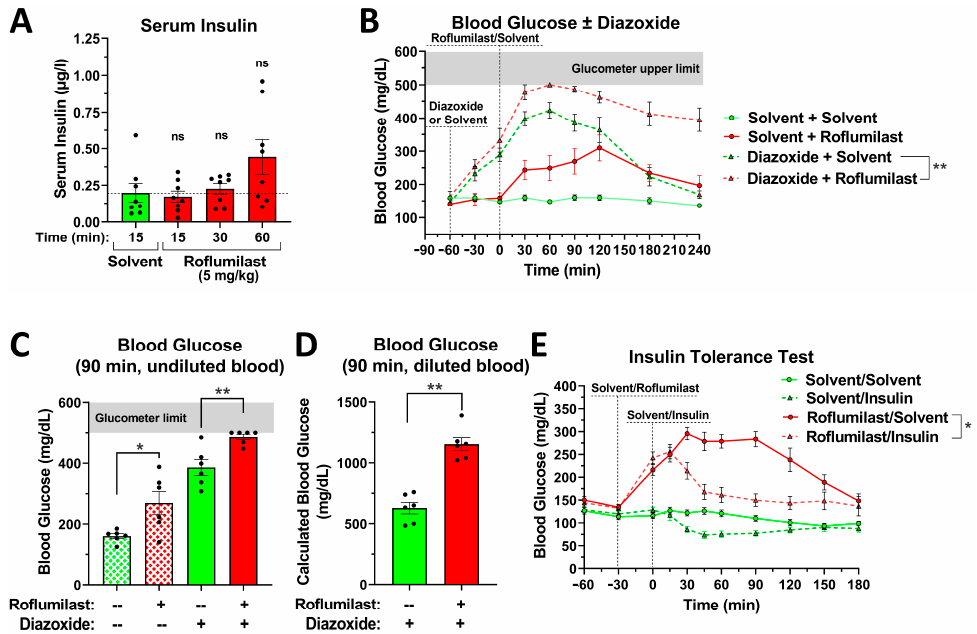
Figure 4. The acute glycemic effects of PDE4 inhibition are not driven by changes in insulin secretion or tissue insulin sensitivity. ( A ) PDE4 inhibition does not lower serum insulin levels. Shown are insulin levels measured in serum of postprandial mice that had been cheek-bled at the indicated times after injection of the PDE4 inhibitor roflumilast (5 mg/kg; i.p.) or solvent control. ( B – D ) Inhibition of insulin release with diazoxide elevates blood glucose levels via a mechanism that is distinct and additive to that of PDE4 inhibition. After 5 h of food deprivation, mice were injected with diazoxide (25 mg/kg; i.p.; n = 6; − 60 min time point) or solvent control, followed 60 min later by a second injection with either the PAN-PDE4 inhibitor roflumilast (5 mg/kg; i.p.; 0 min time point) or solvent control. The glucometer used to measure blood glucose at tail pricks does not read above the upper limit of 500 mg/dL glucose that is indicated by the grey-shaded area. Treatment with roflumilast significantly ( p < 0.01) increased blood glucose levels compared to solvent controls, in both the absence and presence of diazoxide. In ( C , D ), blood glucose levels measured at 90 min after PDE4 inhibitor treatment in the same mice are reported. ( C ) shows the blood glucose levels measured in undiluted blood directly at the mouse tail-vein prick, leading to 4 out of 6 mice in the “diazoxide/roflumilast” group reading at the detection limit of 500 mg/dL. In ( D ), shown are calculated blood glucose levels for the diazoxide-treated groups that were measured after diluting 1 µL of tail-vein blood 1:5 with PBS, thus obtaining readings in the normal range of the glucometer. ( E ) PDE4 inhibition does not impair insulin sensitivity. After 5 h of food deprivation, mice were injected with the PDE4 inhibitor roflumilast (5 mg/kg; i.p.; n ≥ 10; − 30 min time point) or solvent control, followed 30 min later with an injection of insulin (Humulin R; i.p.; 0 min time point) or solvent control. Shown are blood glucose measurements at tail-vein pricks at the indicated time points. The injection of insulin induced a significant reduction ( p < 0.001) in blood glucose levels, in both the absence and the presence of roflumilast. All data represent the mean ± SEM. Statistical significance was determined using the Mann–Whitney test (bar graphs comparing two groups) and the Kruskal–Wallis test, followed by Dunn’s post hoc test to determine the differences between more than two treatment groups or by a two-way ANOVA with Sidak’s post hoc test (time courses), and is indicated as ns ( p > 0.05); * ( p < 0.05); and ** ( p < 0.01).